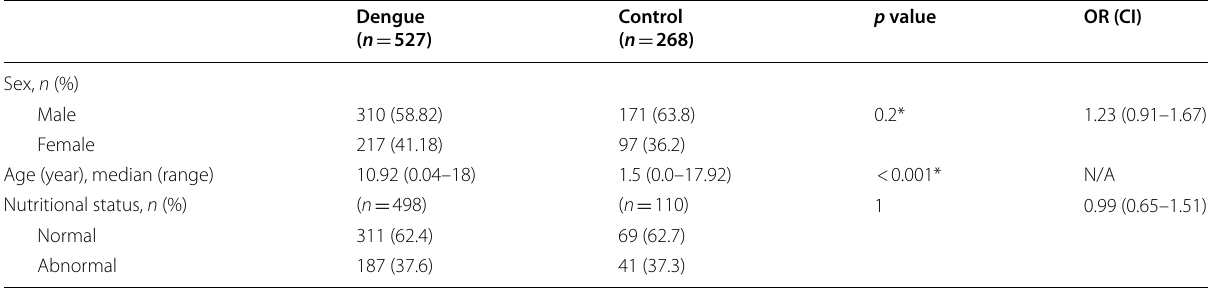
Table 1 Demographic characteristic of dengue and control